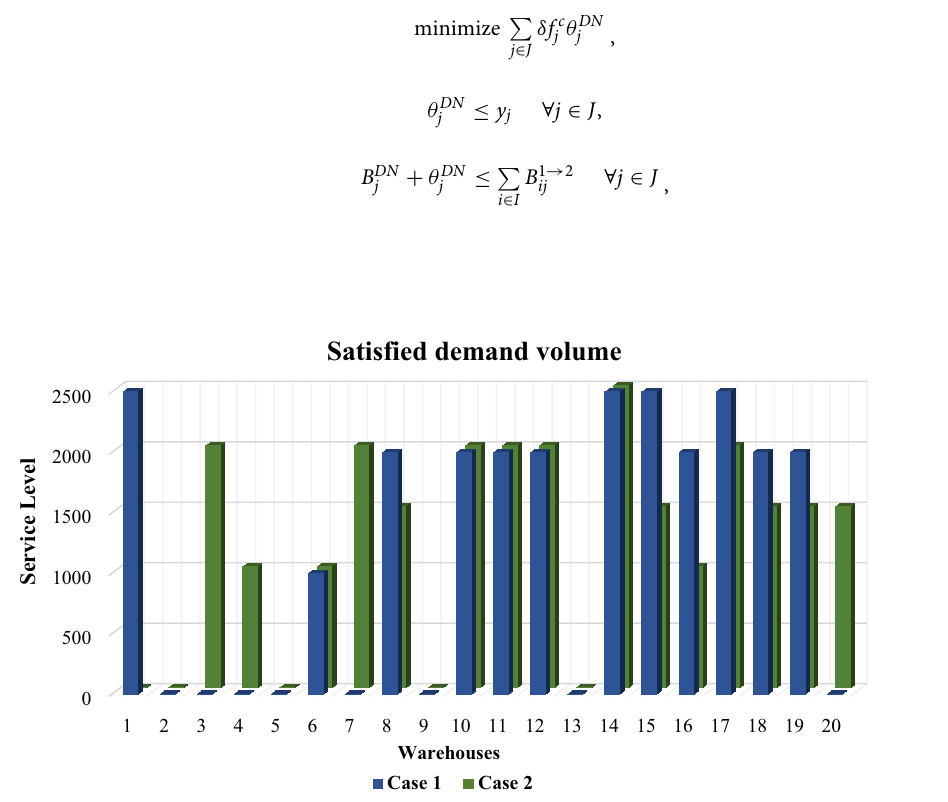
Figure 6. Satisfied demand volume by